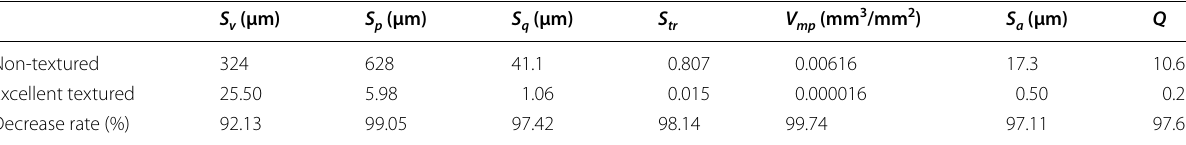
Table 4 Surface topography parameters of disassembly